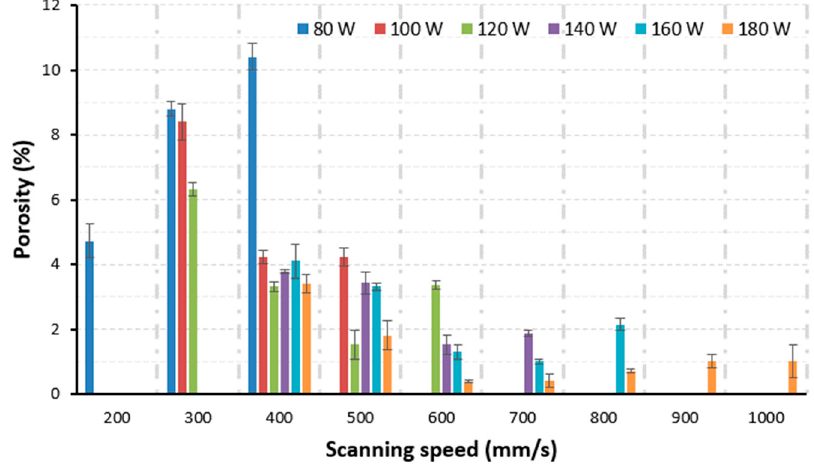
Figure 4. Variation of porosity with scanning speed and laser power at 30-µm layer thickness.